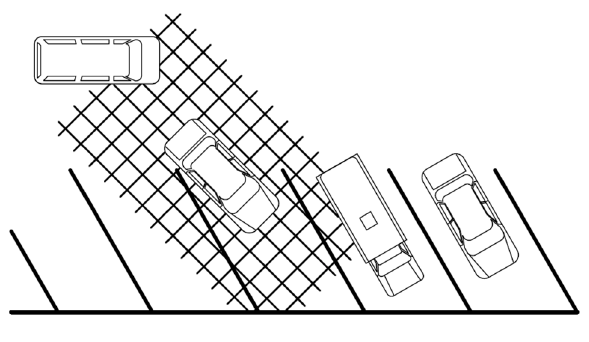
Figure 1. System construction.